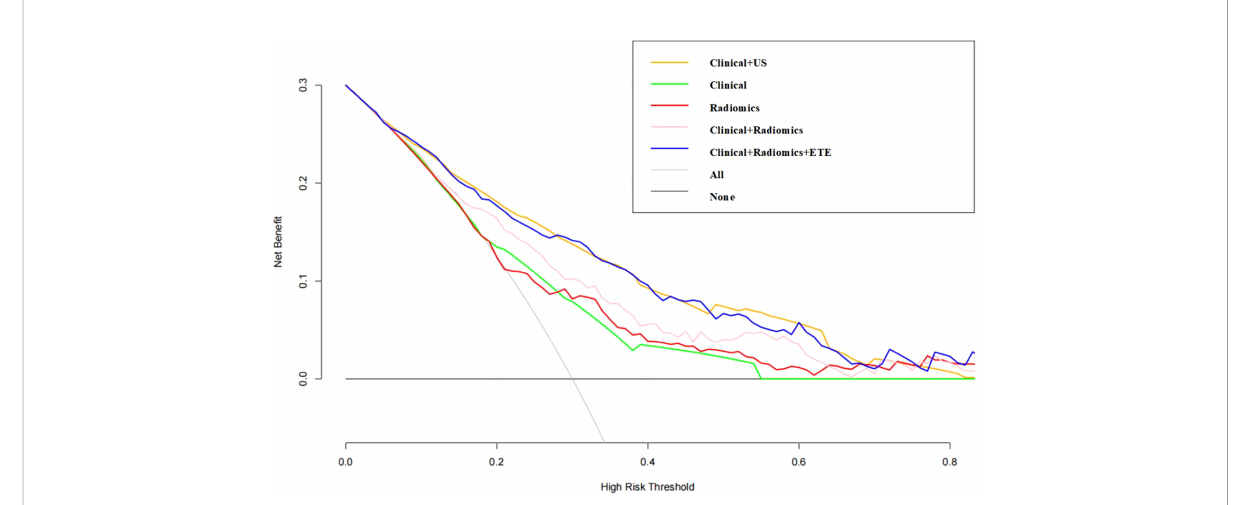
FIGURE 5 Decision curve of the nomogram. The y-axis indicates the net bene fi t; the x-axis indicates the threshold probability. US, ultrasound; ETE, extrathyroidal